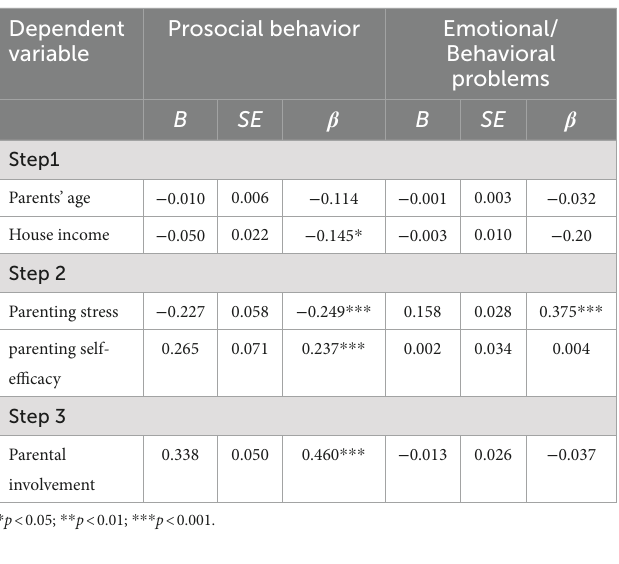
TABLE 3 Relationship between parental involvement and psychological adjustment in children with ASD.